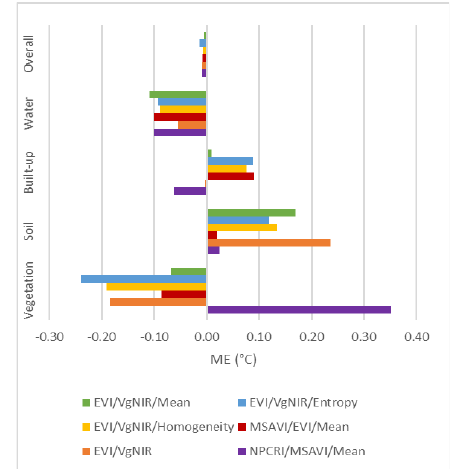
Figure 6. ME of each downscaled LST model